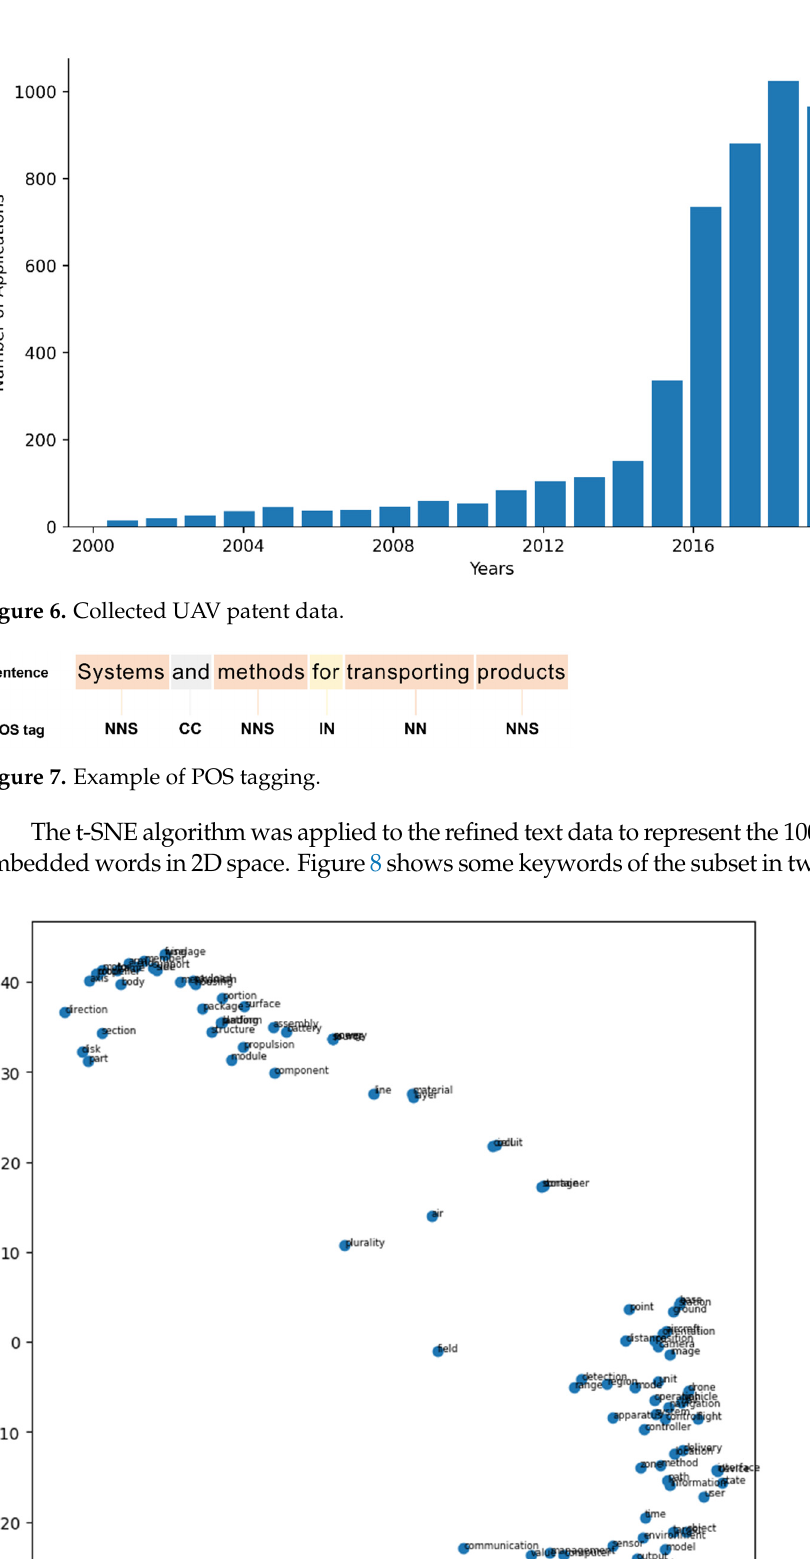
Table 5. Sample for LOF of keywords. Word